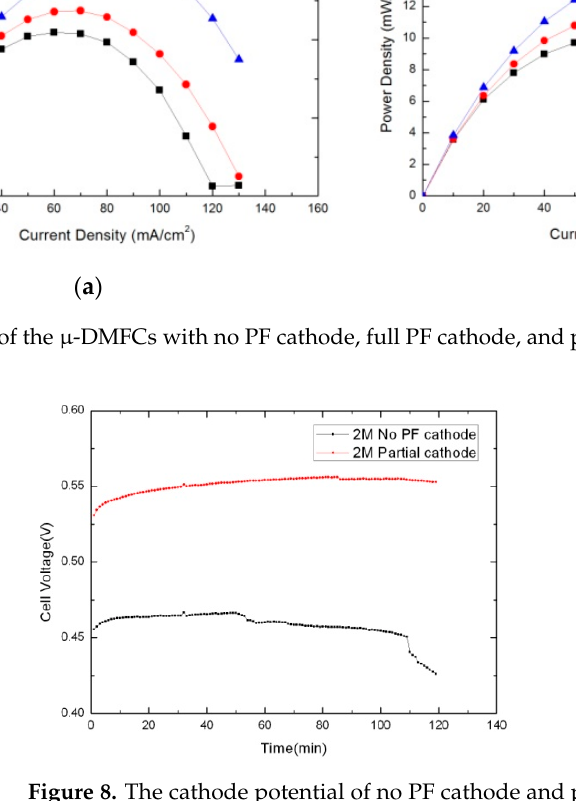
Figure 7. Power density of the μ -DMFCs with no PF cathode, full PF cathode, and partial PF cathode: ( a ) 2 M and ( b ) 4 M methanol solutions.